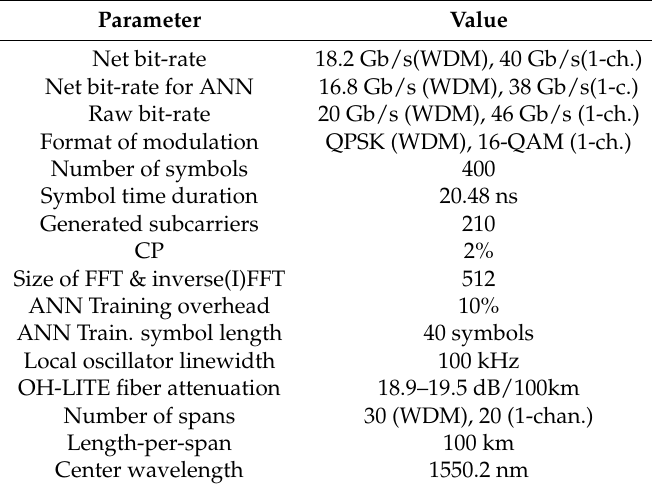
Figure 9. Experimental setup for multi- (upper) and single-channel (lower) CO-OFDM incorporating Volterra-non-linear equalization (V-NLE) and FS-DBP in time domain and the machine learning algorithms in frequency domain (after the FFT in CO-OFDM) [21,22,28,31,33,35,36]. ECL: external cavity laser, AWG: arbitrary waveform generator, AOM: acousto-optic modulator, EDFA: Erbium-doped fiber amplifier, GFF: gain-flattening filter, LO: local oscillator, DFB: distributed feedback laser, ASE: amplified spontaneous emission, PMM: polarization maintaining multiplexer, WSS: wavelength selective switch, BPF: bandpass filter, OSA: optical spectrum analyzer. Inset: received optical spectrum for all channels, highlighting the 5 middle channels. Table 1. Transmission and transceiver OFDM parameters.